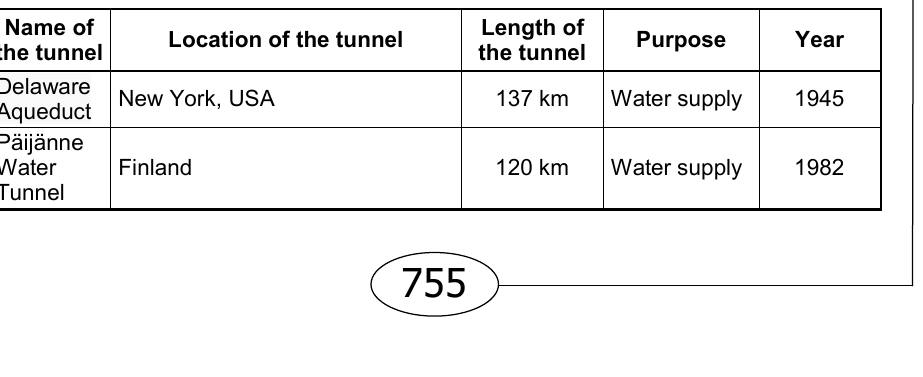
Table 1 – The longest tunnels in the world Таблица 1 – Самые длинные тоннели в